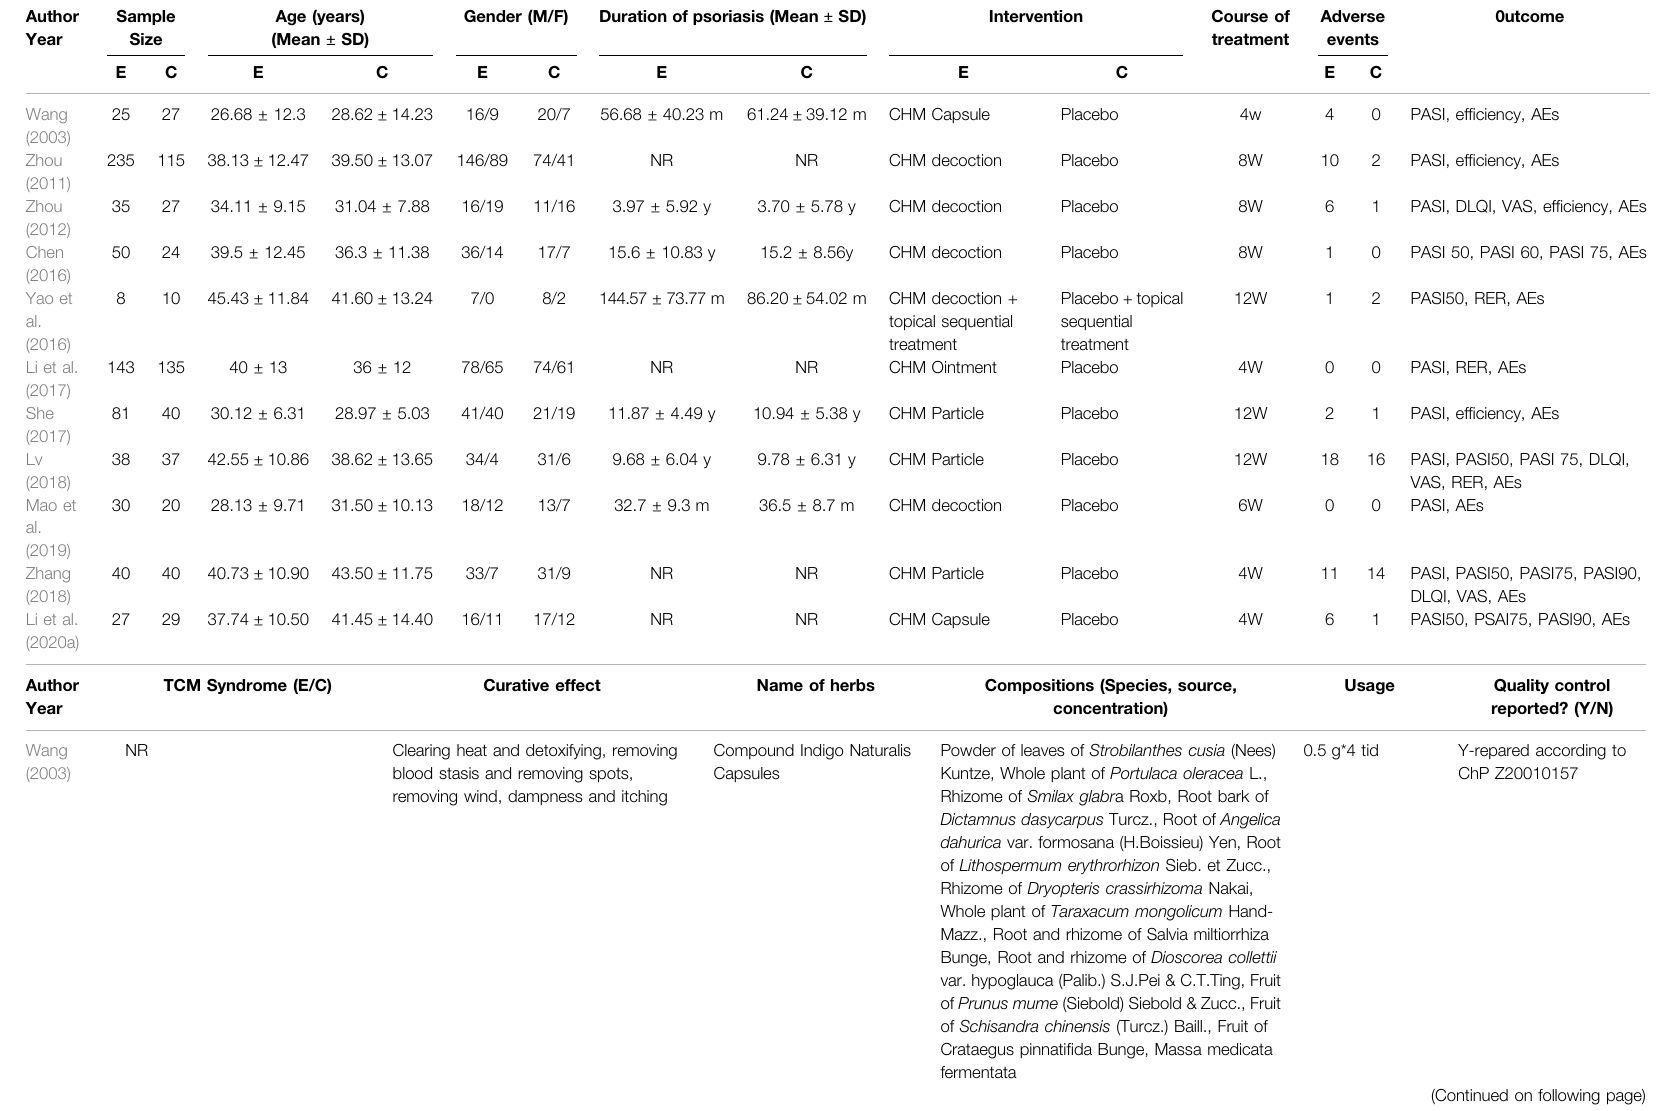
TABLE 1 | Summary of the characteristics of the included